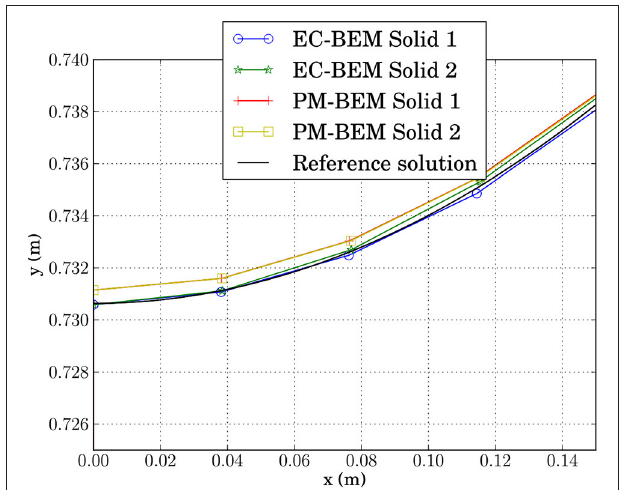
FIGURE 17 | Detailed comparison of the deformed boundaries around the contact zone predicted by EC-BEM and PM-BEM for coarse meshes (Meshes 1 and 2 of Table 6 ) together with the Reference solution by PM-BEM (using Mesh 3 of Table 6